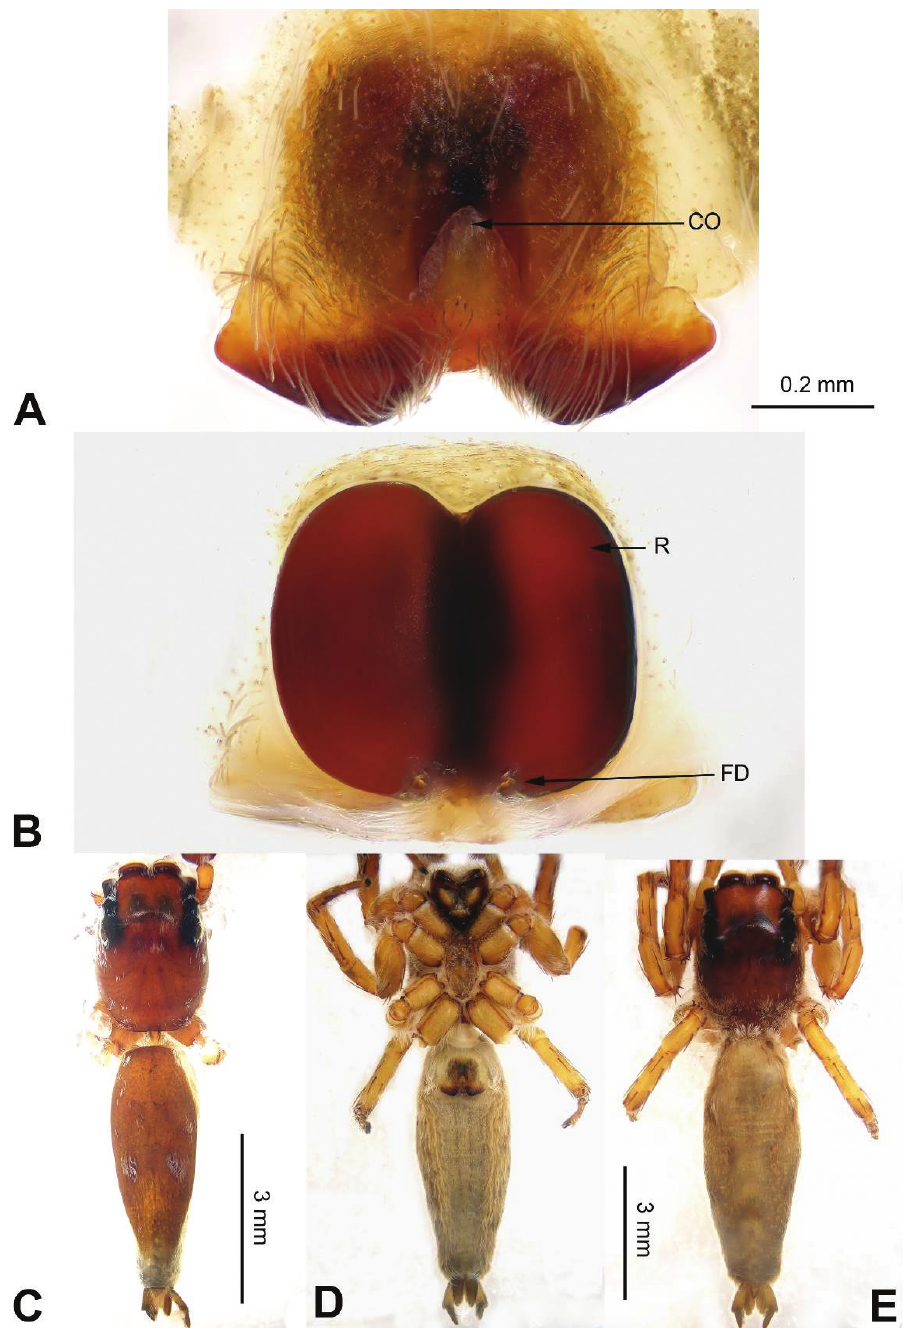
Figure 18. Cocalus menglaensis sp. n., female paratype and male holotype. A epigyne, ventral B vulva, dorsal C male habitus, dorsal D female habitus, dorsal E female habitus, ventral. Scale bars equal for A and B ; equal for D and E